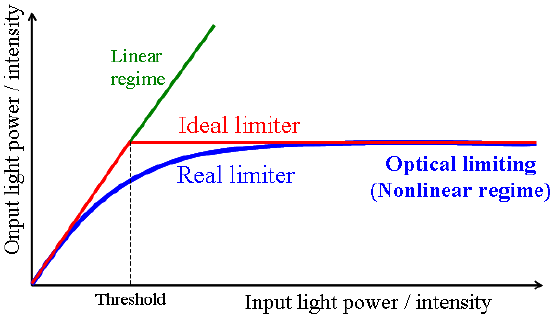
Figure 1. Optical limiting functionality.